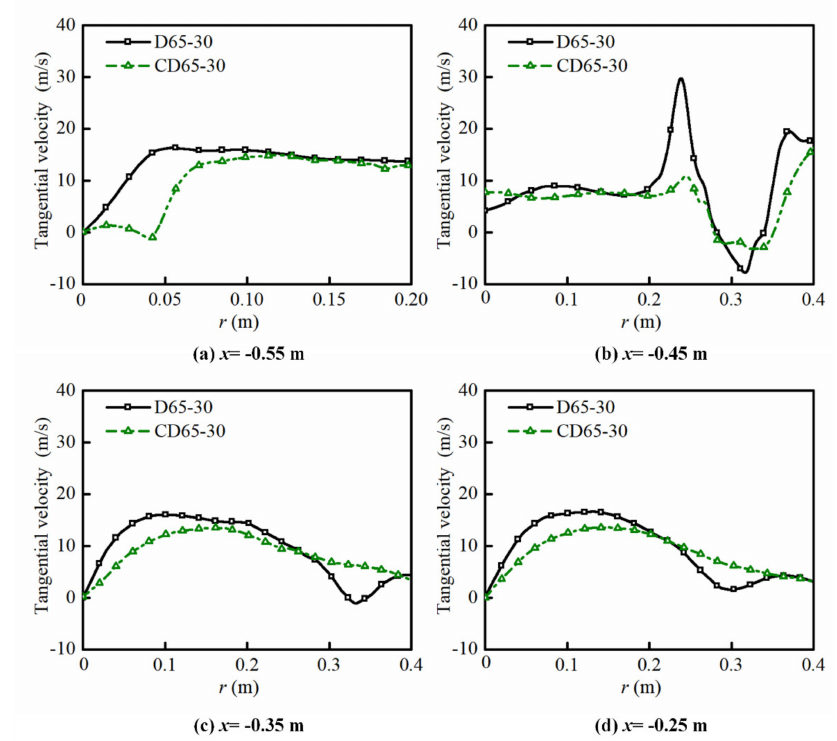
Figure 7. Tangential velocity of D65-30 and CD65-30 at different axial